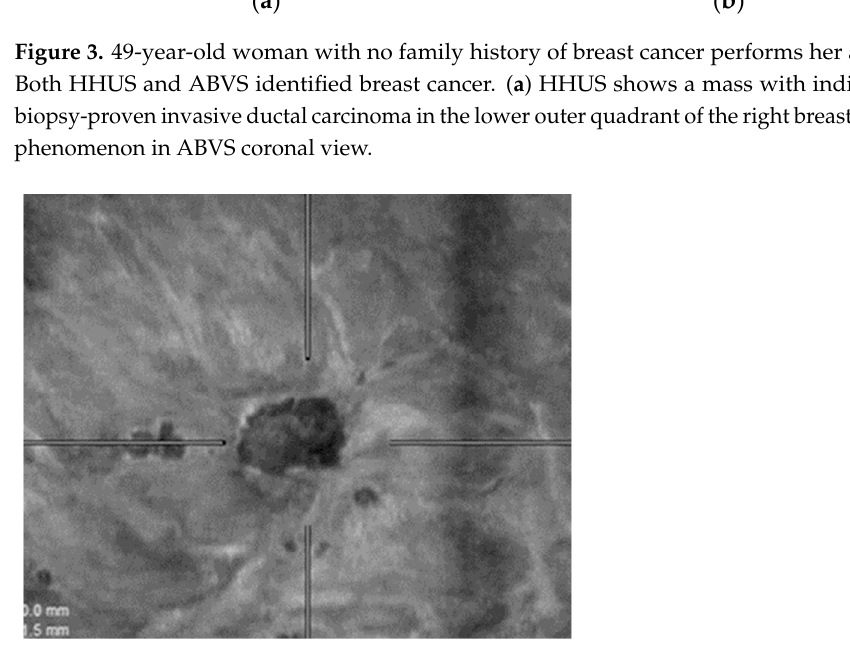
( b ) Figure 5. A false-positive case from ABVS caused by nipple artifact. Routine screening for a 67-year- old woman. ( a ) small architectural distortion is seen on ABVS coronal view near the nipple. ( b ) Negative HHUS examination. ( a ) ( b ) Figure 6. 44-year-old woman comes to our institute for her first mammography. HHUS ( a ) shows a small nodule (triple negative invasive ductal carcinoma). Instead, there was a negative ABVS exam- ination ( b ).